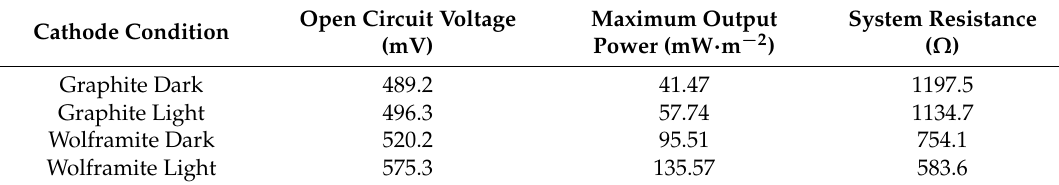
Figure 5. Polarization ( a ) and power density curves ( b ) of MFCs equipped with wolframite-coated graphite cathodes and bare graphite cathodes under dark/light conditions. Table 1. The average electrical parameters of electron transfer in reaction systems.